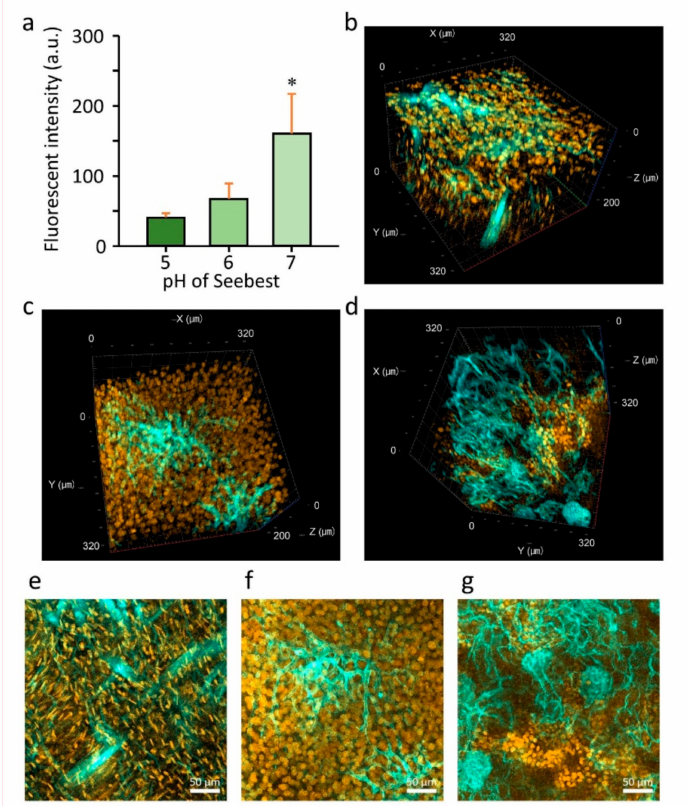
Figure 4. Visualization of the Dox spatial distribution. ( a ) Dox release during tissue clearing in Seebest (pH 5–7). Each bar represents the mean + S.D. of three experiments. Statistical comparison was performed using Dunnett’s test. * p < 0.05 vs. pH 5 group. ( b – d ) Dox (orange) and DiD-stained blood vessel (cyan) visualization in ( b ) the heart, ( c ) liver and ( d ) kidney. Maximum intensity projections of ( b – d ) were also presented in ( e – g ), respectively. Scale bars represent 50 µ m. Seebest pH was 6. Fluorescence images were acquired as a z-stack at 1.222- µ m intervals using a confocal microscope with a × 25 LD LCI Plan-Apochromat objective lens. Acquisition settings were as follows: zoom, 1.0; xy scaling, 0.664 µ m; spectral emission filters (bandwidth), 527–600 nm and 639–758 nm; laser wavelengths, 488 and 633 nm for Doxorubicin (DOX) and DiD, respectively. Each image was representative of three